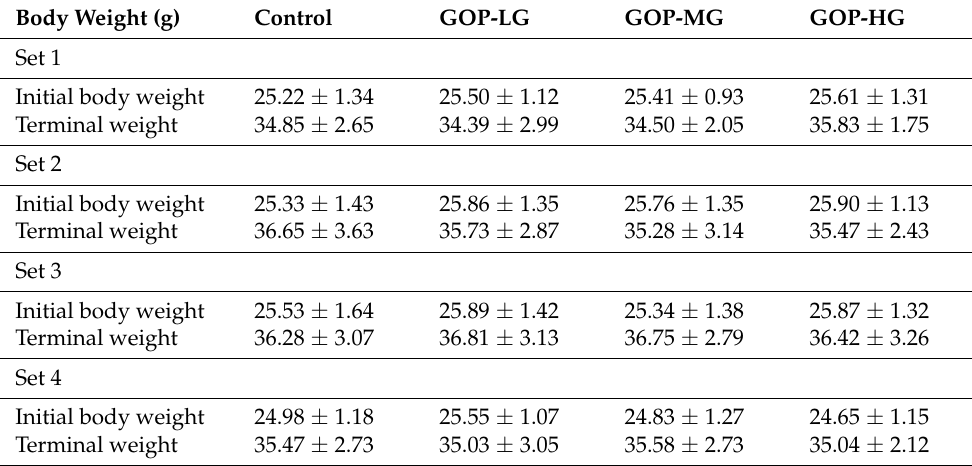
Table 2. Effects of GOP on the body weight in